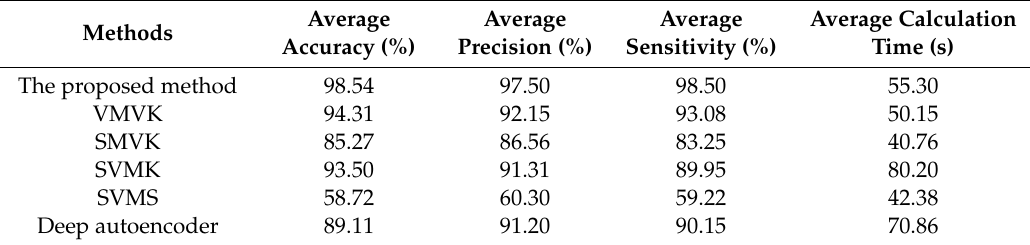
Figure 13. The single diagnosis results of the contrastive methods for the six experiments: ( a ) AC; ( b ) PR; ( c ) SE. Table 6. The average diagnosis results of the contrastive methods for the six experiments.